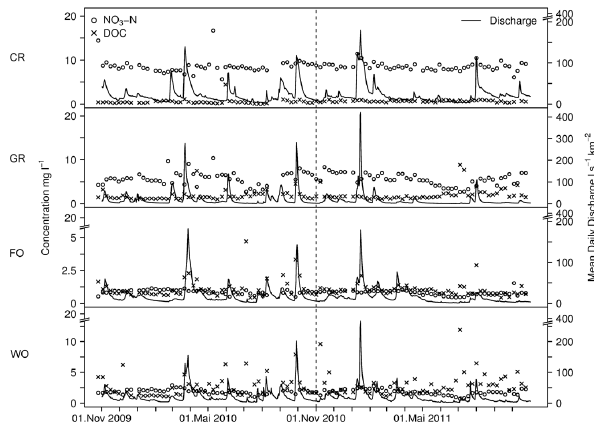
Fig. 3. Time-series of measured concentrations for NO 3 -N and DOC, and mean daily discharge at the catchments representing dif- ferent land-use types “Crops” (CR), “Grassland” (GR), and “For- est” (FO) and at the “Watershed Outlet” (WO). Scales for con- centration and daily discharge vary with the catchments due to different magnitudes. Discharge data for WO was provided by LfULG